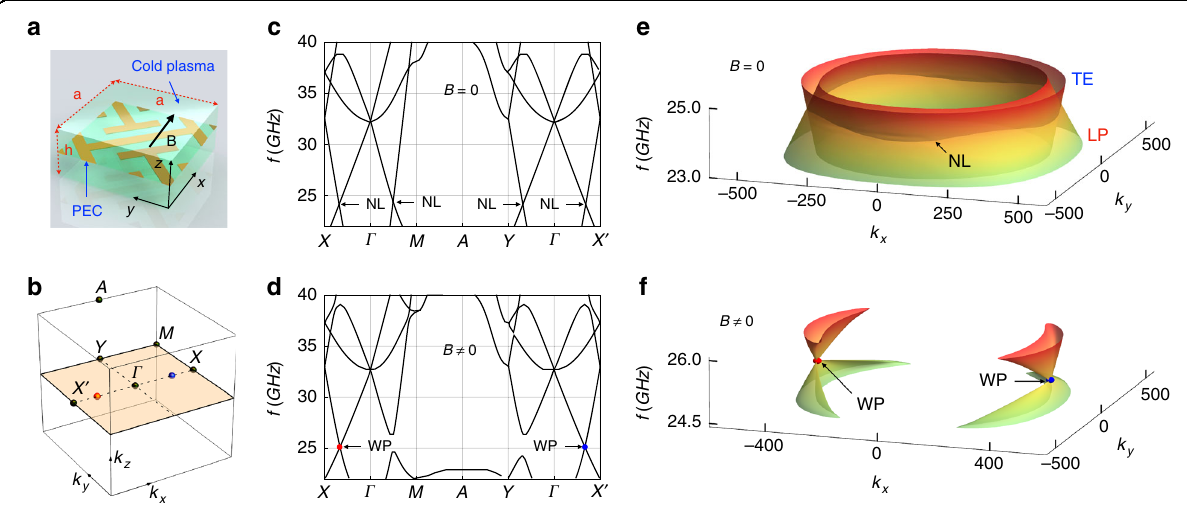
Fig. 2 Realization of the minimal ideal photonic Weyl metamaterial. a Unit cell with in-plane period a = 5 mm and thickness h = 2 mm. The lengths of the long and short arms of the metallic (PEC) structure are 1.1 a and 0.5 a , respectively. The width of all metallic (PEC) wires is 0.1 a , and the thickness is 35 μ m. The metallic (PEC) structure is embedded in a magnetized plasma with electron density 2 × 10 12 cm − 1 under a 0.5 T static magnetic fi eld B in the x direction. b Bulk BZ with the high-symmetry points [involved in c and d ] highlighted by black dots. The two WPs [red and blue dots, observed in d ] are located along the Γ − X and Γ − X ′ directions. c Simulated band structure along high-symmetry lines when the TRS is respected ( B = 0). Three degenerated points are found at the frequency f n = 24.1 GHz, reminding us of the NL in the k x – k y plane. d Same as c but for the broken TRS ( B ≠ 0). Two WPs (red and blue dots) are observed at the frequency f w = 25.1 GHz. e , f 3D views of the band structures in the k x – k y plane for the NL and Weyl metamaterials, respectively, wherein the NL and WPs are